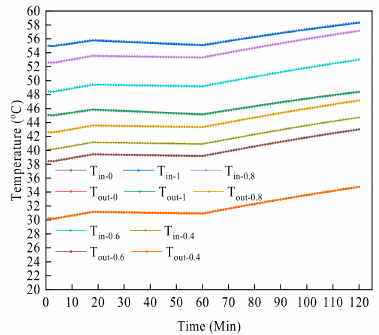
Figure 5. Diagram of verification of the heat exchanger in TRNSYS, essentially an efficiency